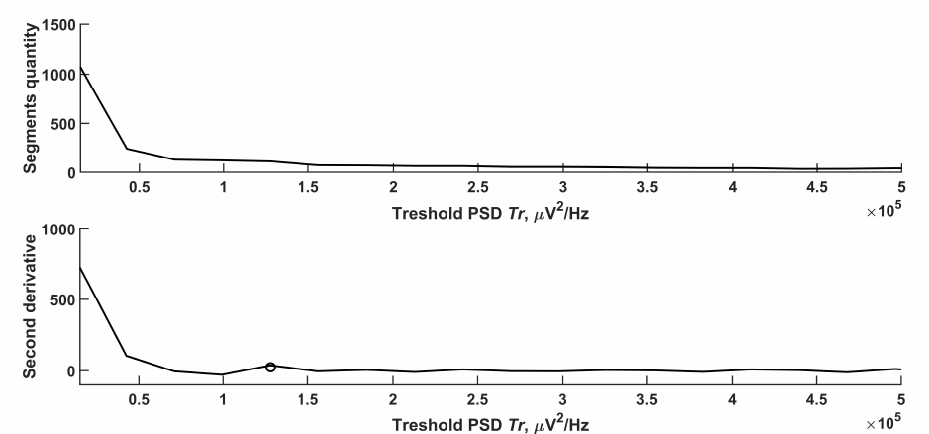
Figure 5. Histogram of the number of ridge segments from the threshold PSD Tr . The circle marks the local maxima at threshold value Tr = 1.27 × 10 5 µ V 2